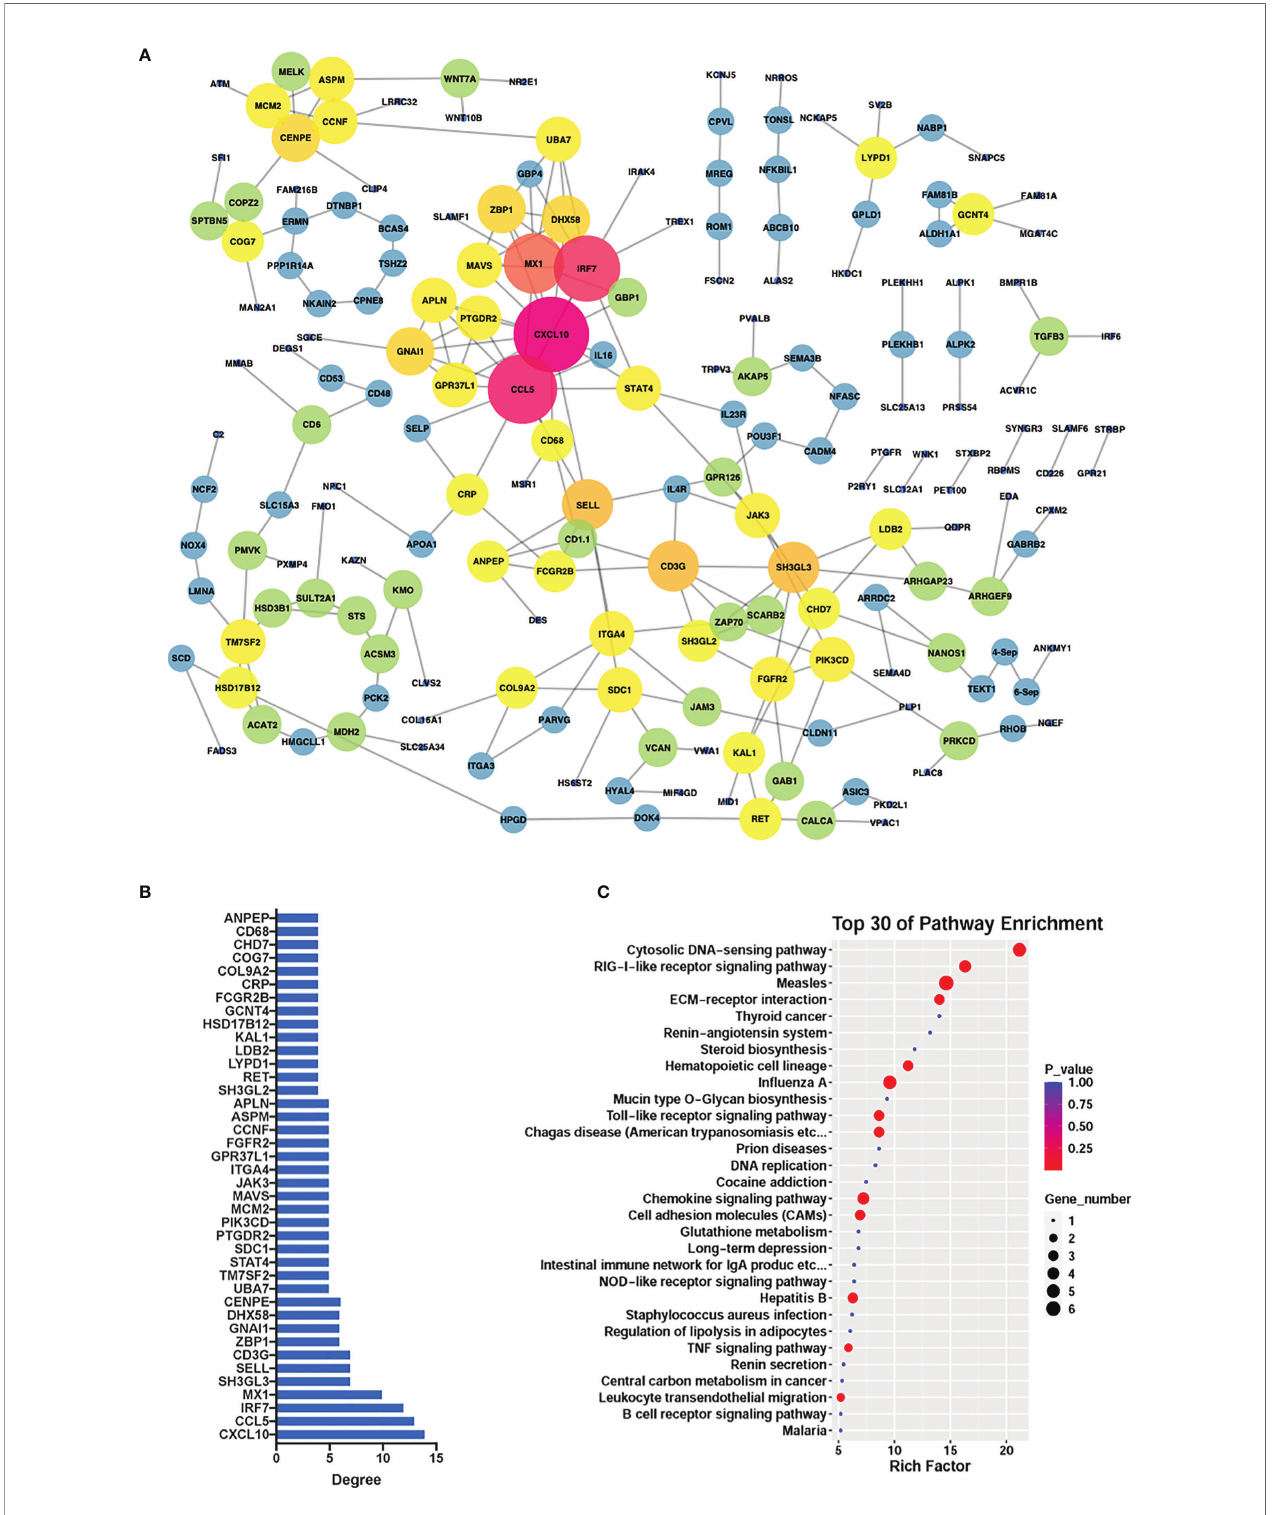
FIGURE 7 | PPI network. (A) PPI network constructed from signi fi cantly differentially expressed and methylated genes in G. parasuis -infected porcine brain. Nodes represent genes and edges represent interactions. The node size represents the node degree. (B) The top 40 hub genes with the highest node degrees corresponding to the network. The vertical axis shows gene name, and the horizontal axis shows the node degree. (C) KEGG pathway enrichment of the top 40 hub genes. Top 30 KEGG pathways are shown in the vertical axis and the horizontal axis shows the rich